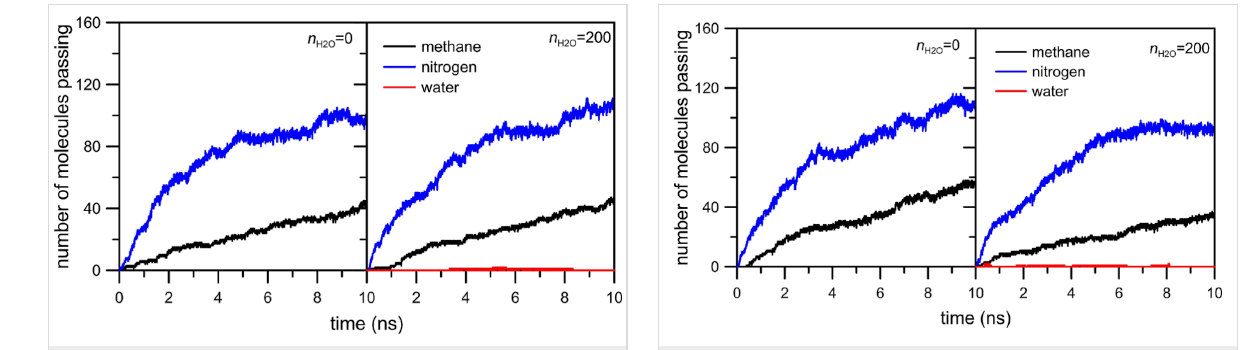
Figure 3: The influence of water on the number of methane and nitrogen molecules passing through an HH nanopore.